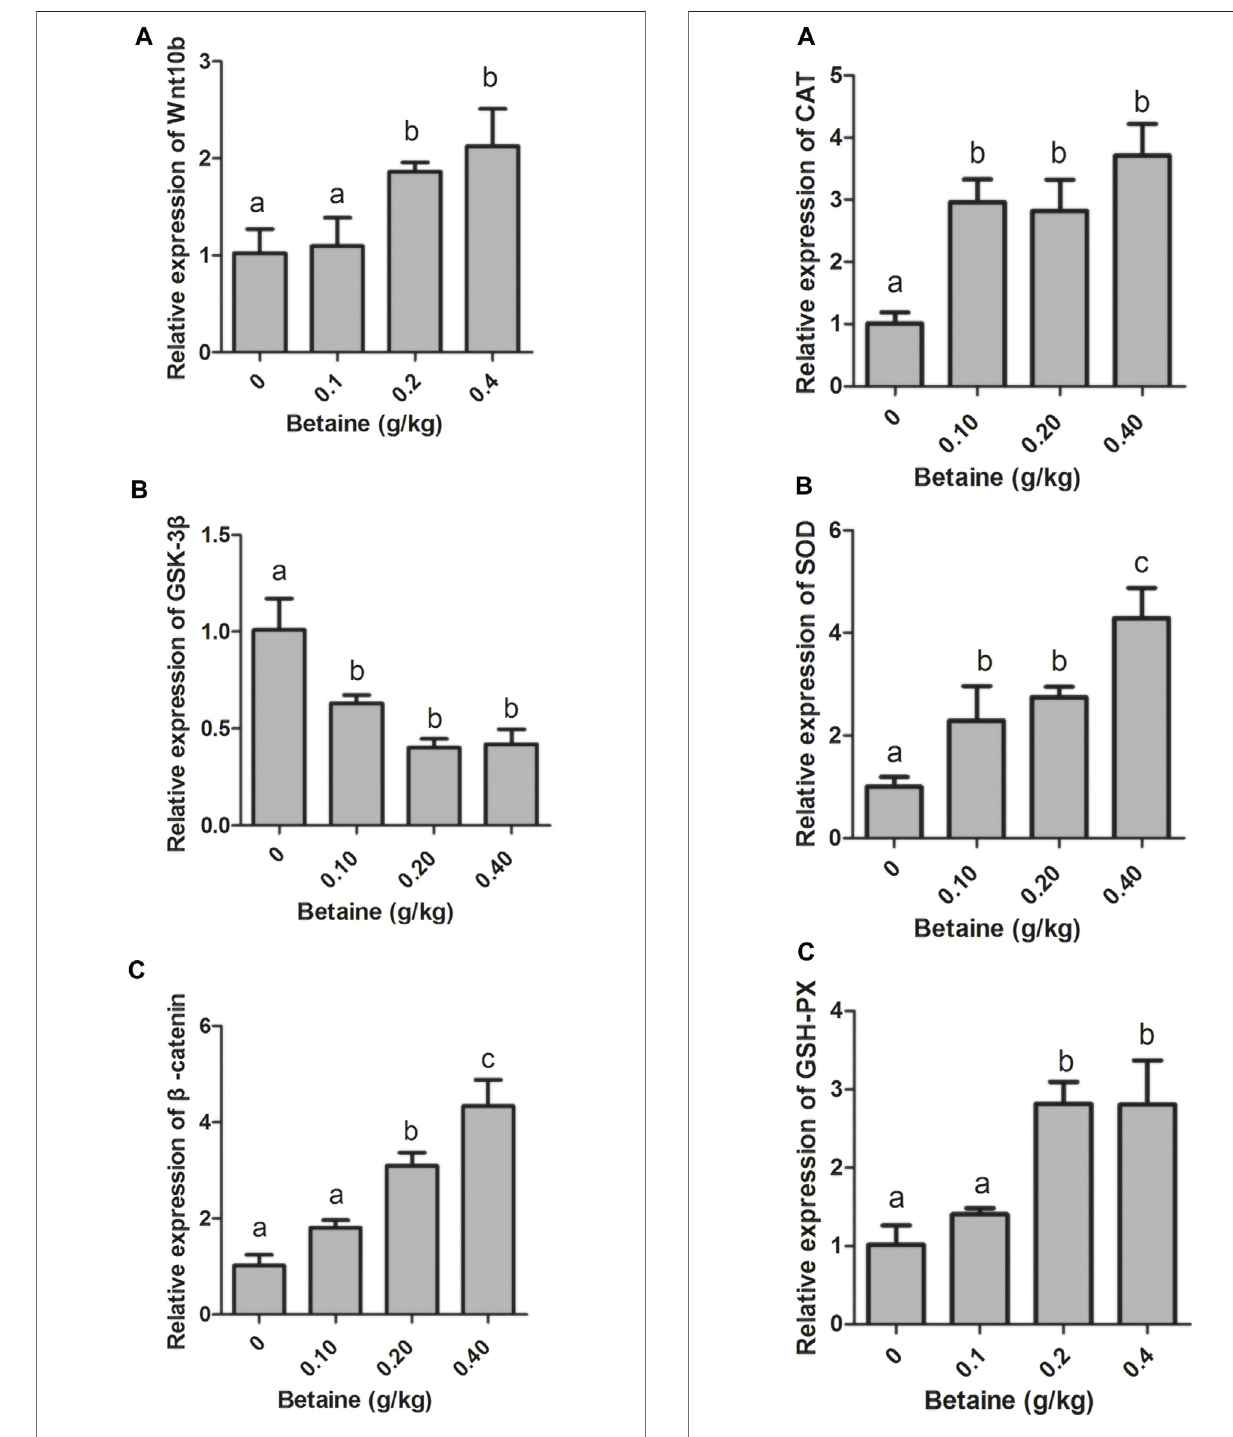
FIGURE1 | Effect ofbetaineon the mRNAexpression ofWnt10b, GSK- 3 β , and β -catenin in the liver of zebra fi sh. (A) The mRNA expression of Wnt10b; (B) The mRNA expression of GSK-3 β ; (C) The mRNA expression of β -catenin. Values are expressed as means ± sem ( n = 3). Statistically signi fi cant differences are denoted by different letters ( p < 0.05).